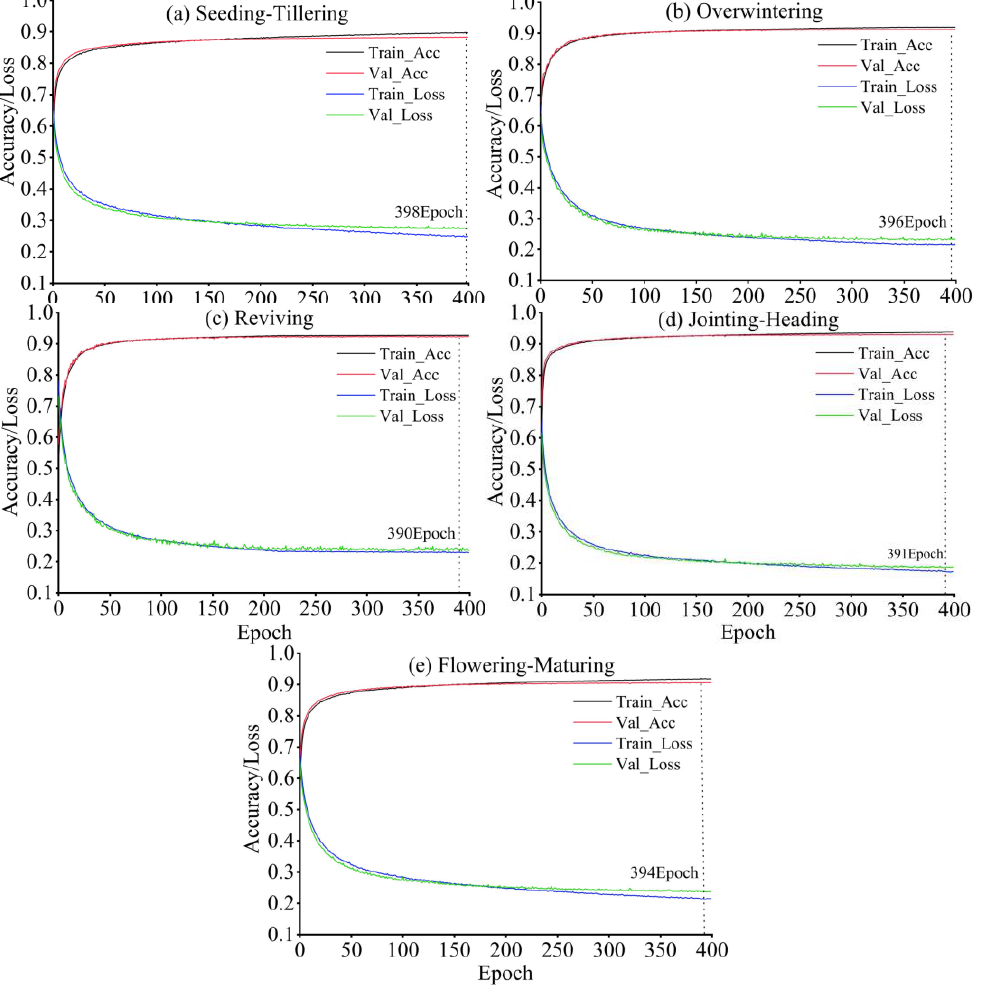
Figure 5. Accuracy and loss functions of the training and validation sets for different growth periods. The black curve represents the training set accuracy, the red curve represents the validation set accuracy, the blue curve represents the loss function of the training set and the green curve represents the loss function of the validation set. The dotted line marks the number of training epochs corresponding to the optimal weight.